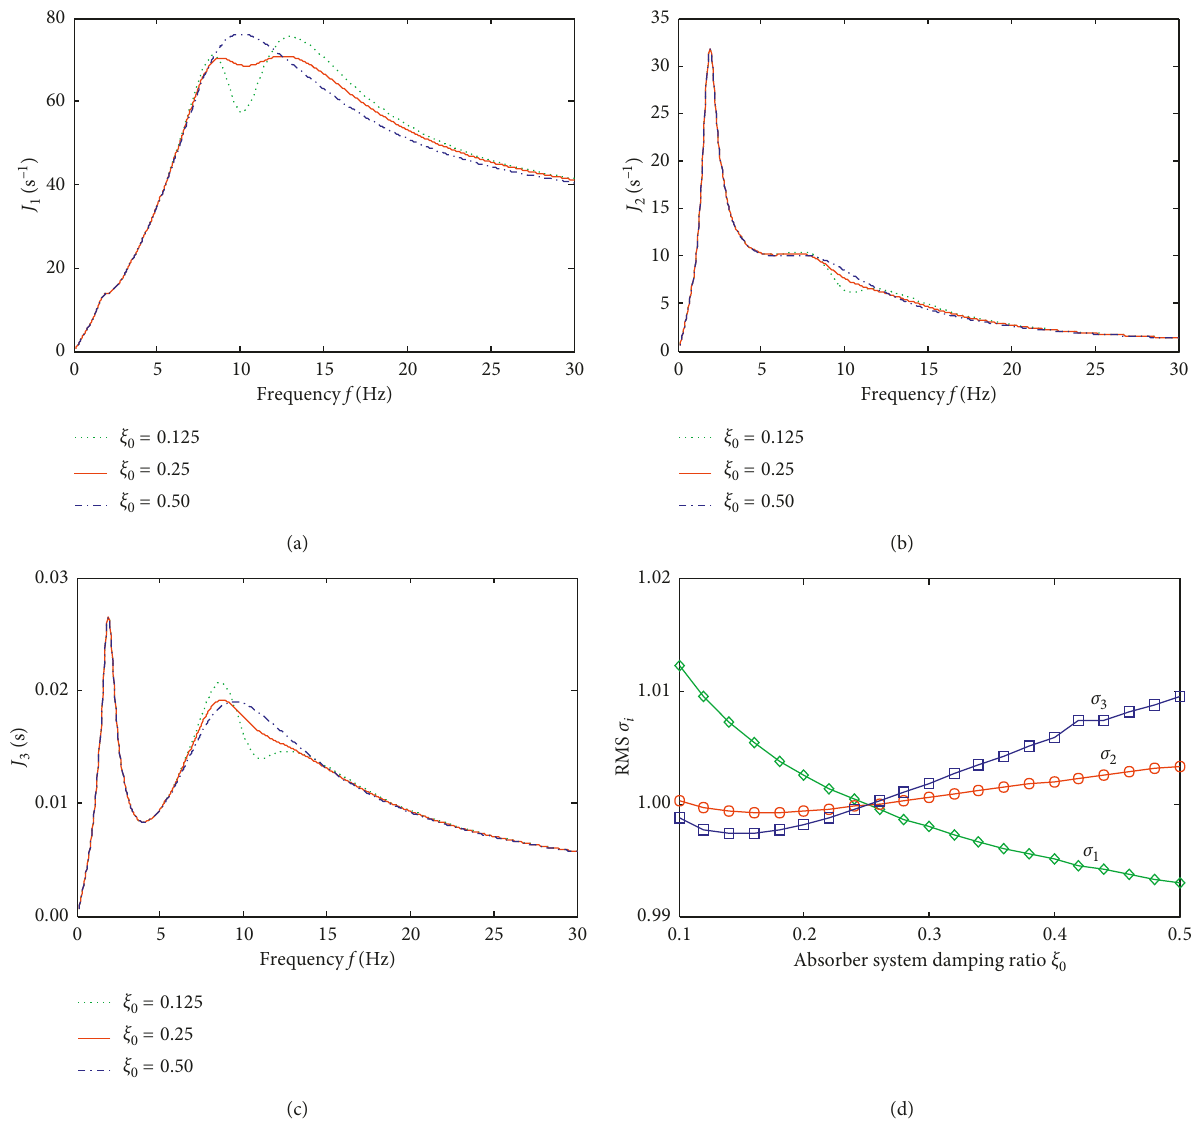
Figure 8: Influences of ξ on € z , € z , and f : (a) the amplitude frequency characteristics J 0 1 2 d at different values of ξ ; (c) the amplitude frequency characteristics J frequency characteristics J 2 0 σ , and σ versus ξ 2 3 0